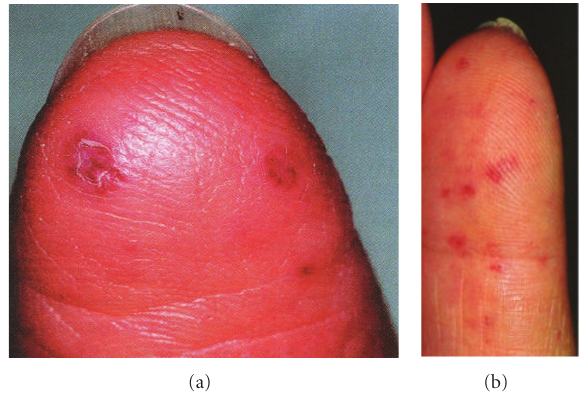
Figure 17: Hereditary hemorrhagic Telangiectasia ((a) [4, page 844], (b) [9, page